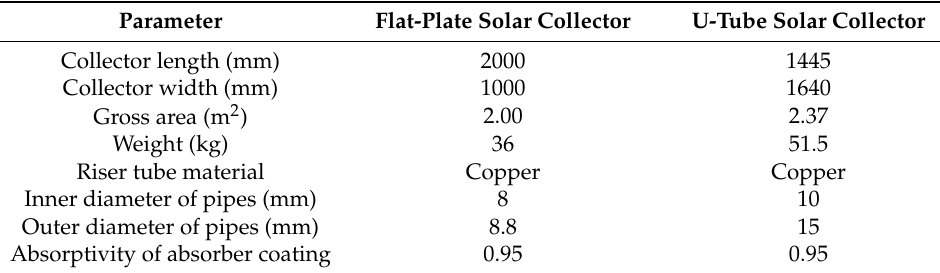
Table 2. Specifications of the solar